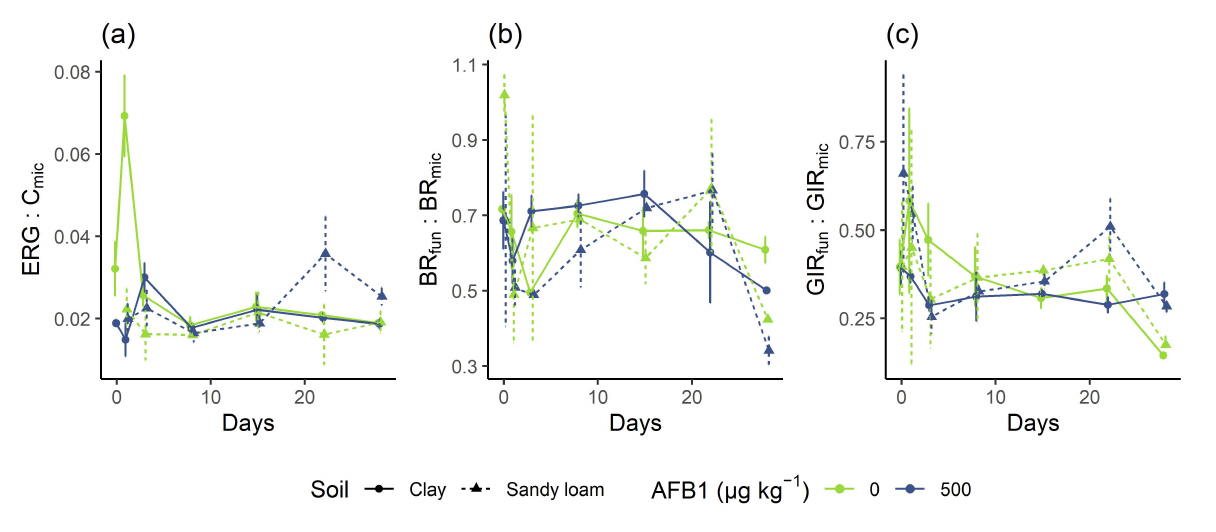
Figure 5. Biomass and activity ratios in AFB1-exposed (500 µg kg −1 ) and control soil as a function of incubation time. Curve plots showing fungal-to-microbial ratios for the biomass ERG:C mic ( a ), basal respiration BR fun :BR mic ( b ), and glucose-induced respiration GIR fun :GIR mic ( c ).